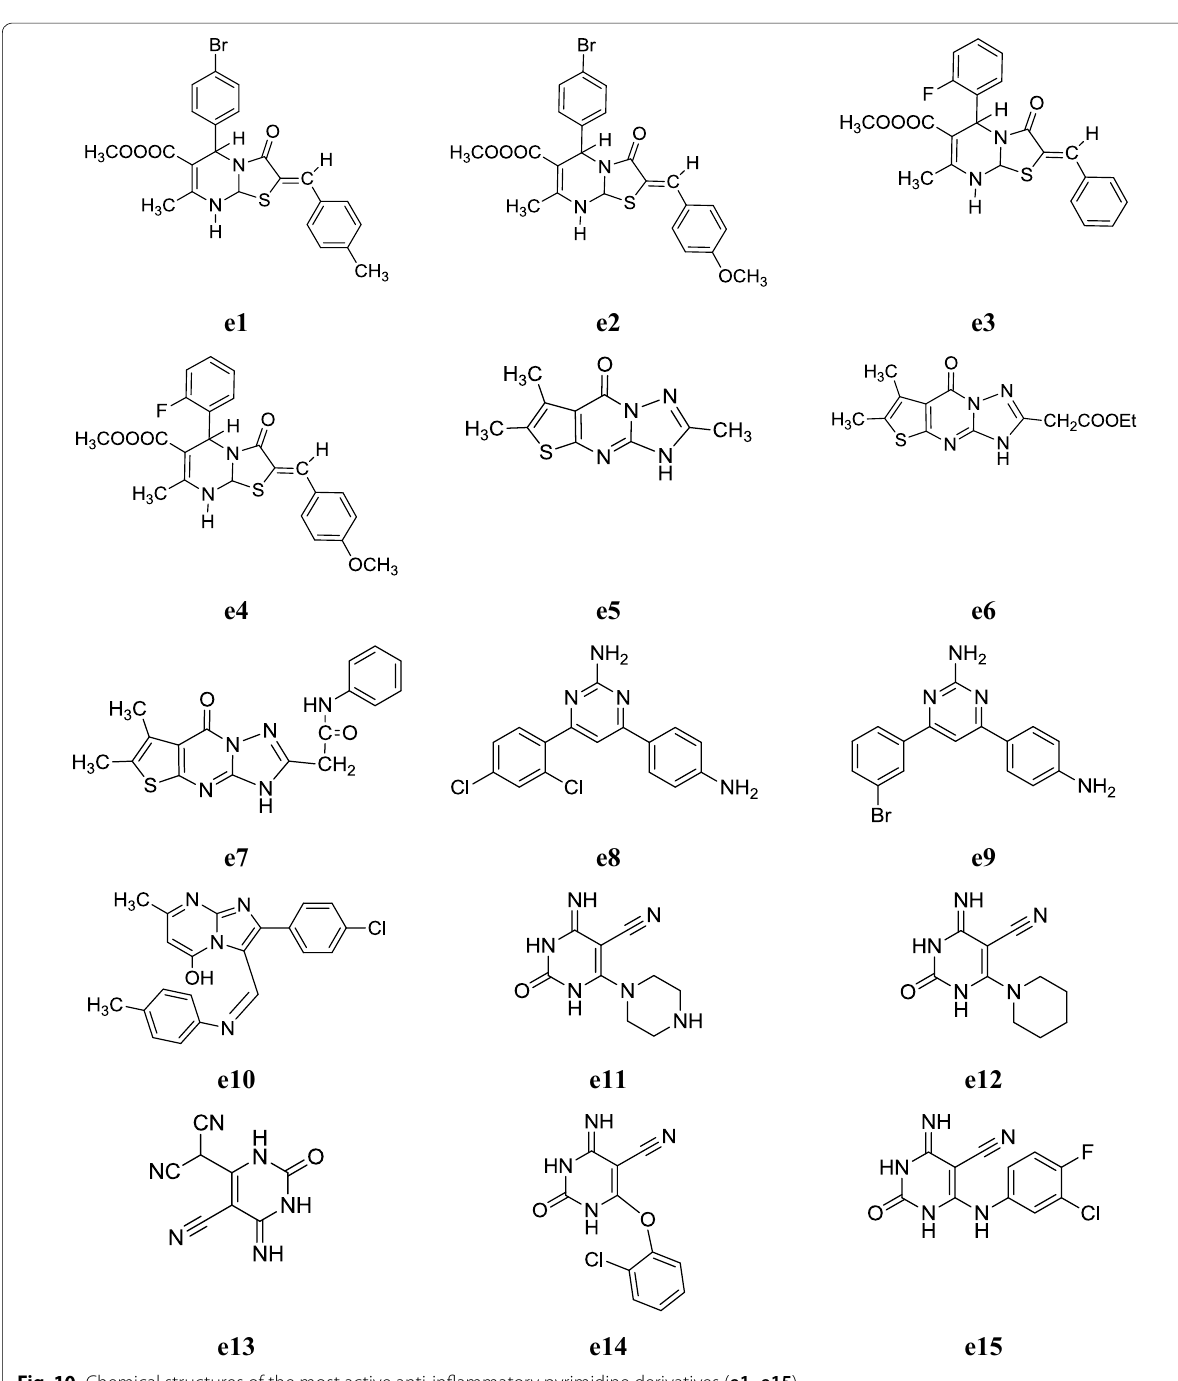
Fig. 10 Chemical structures of the most active anti-inflammatory pyrimidine derivatives ( e1 – e15